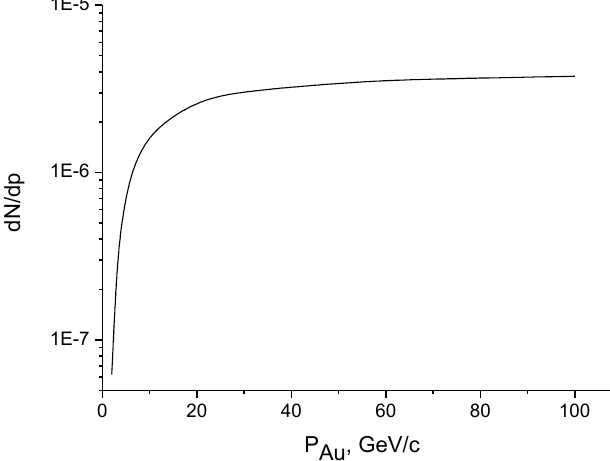
Figure 1b. Cross section of the D+D- meson production at 0ºand 10 MeV in Au-Au collisions as a function of momentum of colliding